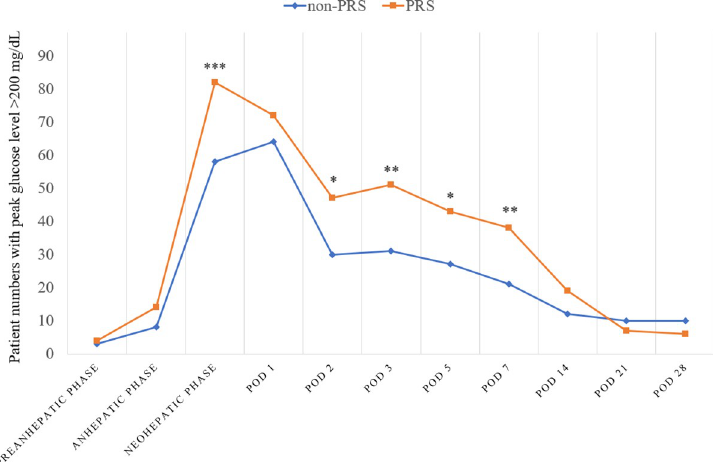
Fig 3. Comparison of intra- and postoperative hyperglycemia occurrence (peak glucose level > 200 mg/dL) between propensity score-matched patients with or without postreperfusion syndrome (PRS). � p < 0.05, �� p � 0.01, and ��� p � 0.001. POD, postoperative day.